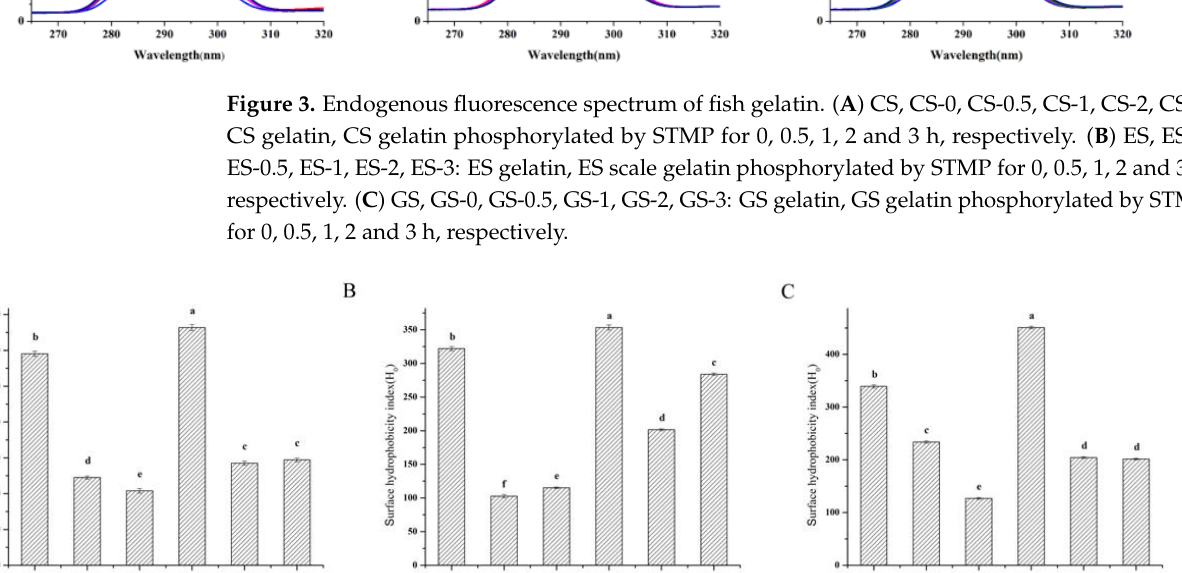
Figure 4. Surface hydrophobicity index of fish gelatin. ( A ) CS, CS-0, CS-0.5, CS-1, CS-2, CS-3: CS gelatin, CS gelatin phosphorylated by STMP for 0, 0.5, 1, 2, 3 h respectively. ( B ) ES, ES-0, ES-0.5, ES-1, ES-2, ES-3: ES gelatin, ES scale gelatin phosphorylated by STMP for 0, 0.5, 1, 2, 3 h respectively. ( C ) GS, GS-0, GS-0.5, GS-1, GS-2, GS-3: GS gelatin, GS gelatin phosphorylated by STMP for 0, 0.5, 1, 2, 3 h respectively. Different lowercase letters denote significant differences ( p <